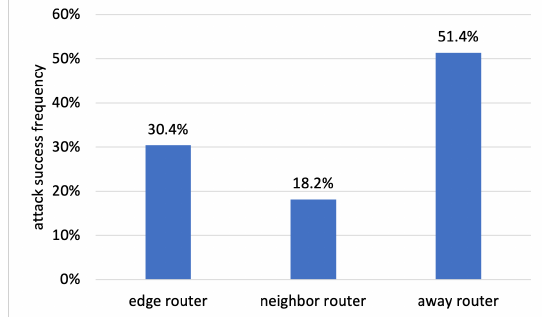
Figure 15. Determination of the target locations in AT&T topology.